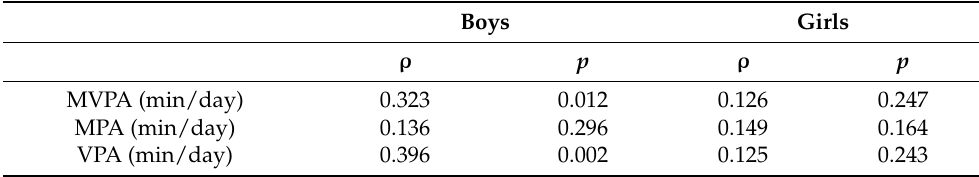
Table 2. Spearman’s rank correlations between the questionnaire-based assessment and SWA-based measures of the time spent in MVPA, MPA and VPA for female and male adolescents.